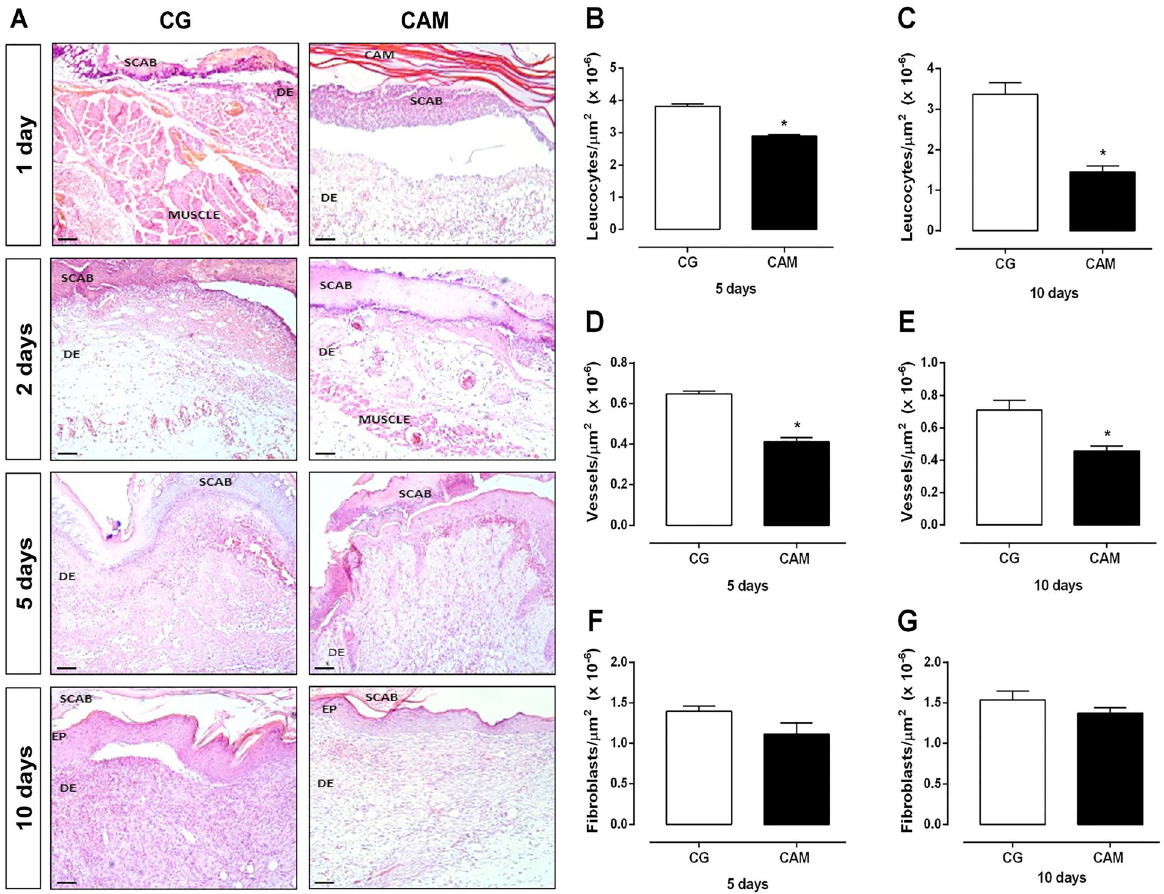
Figure 3. A , Microscopic aspect of skin excisional wounds in the control (CG) and chitosan and alginate membrane (CAM) groups, 0, 2, 4, 6, and 10 days post-wounding. Sections were stained with hematoxylin and eosin, and the images were acquired under a fi nal magni fi cation of 10 (cid:3) (scale bars: 100 m m). DE: dermis; EP: epidermis; SCAB: dry scab. Quanti fi cation of leucocytes ( B and C ), vessels ( D and E ), and fi broblasts ( F and G) on days 5 and 10 post-wounding. Data are reported as means ± SE of 5 animals per group. *P o 0.05 vs CG (Student ’ s t